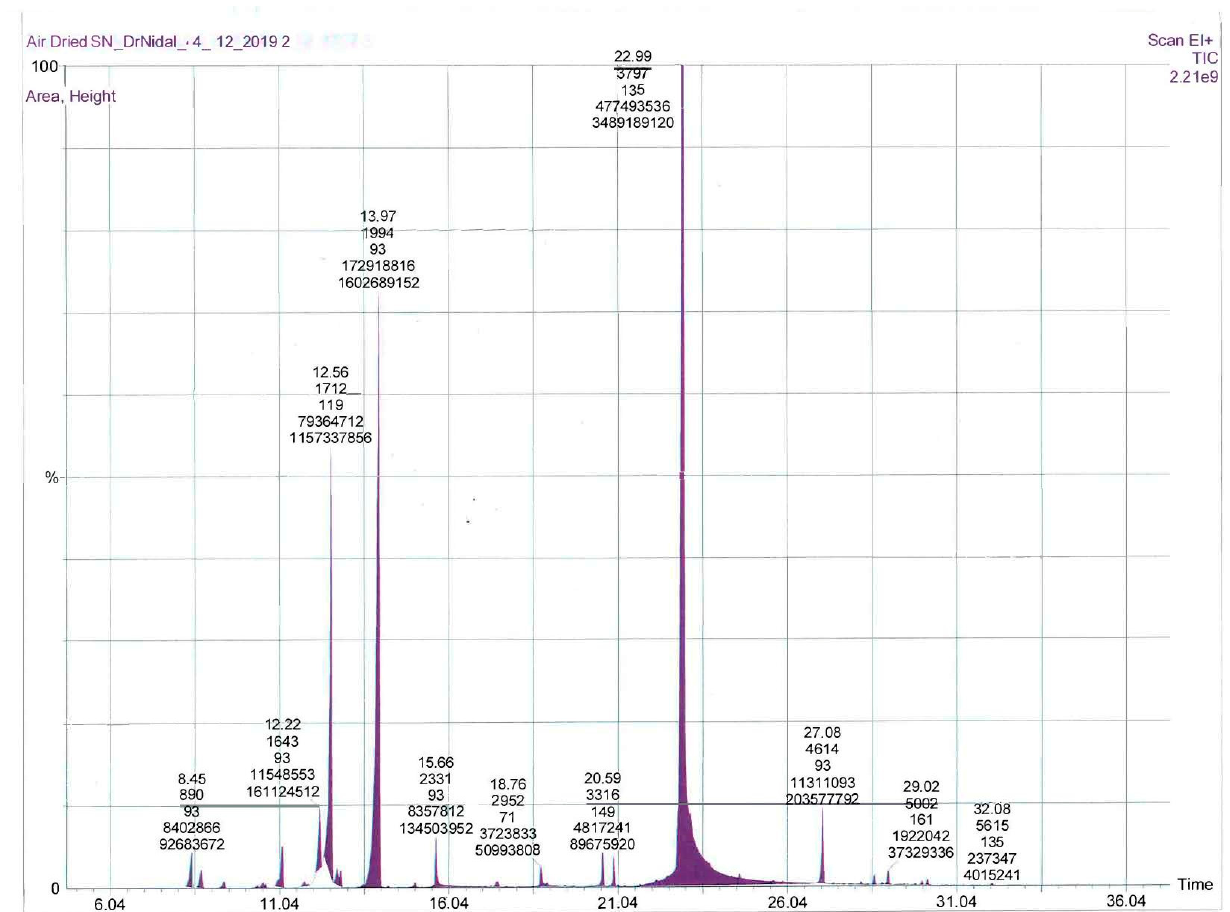
Figure 2. GC-MS chromatogram of the essential oils from air-dried S. nabateorum.